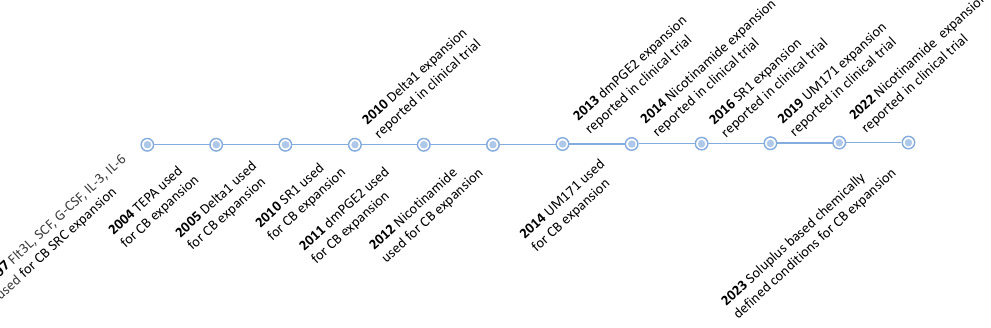
Figure 2. Timeline of culture conditions for improving HSC expansion. This figure was created using Microsoft PowerPoint.